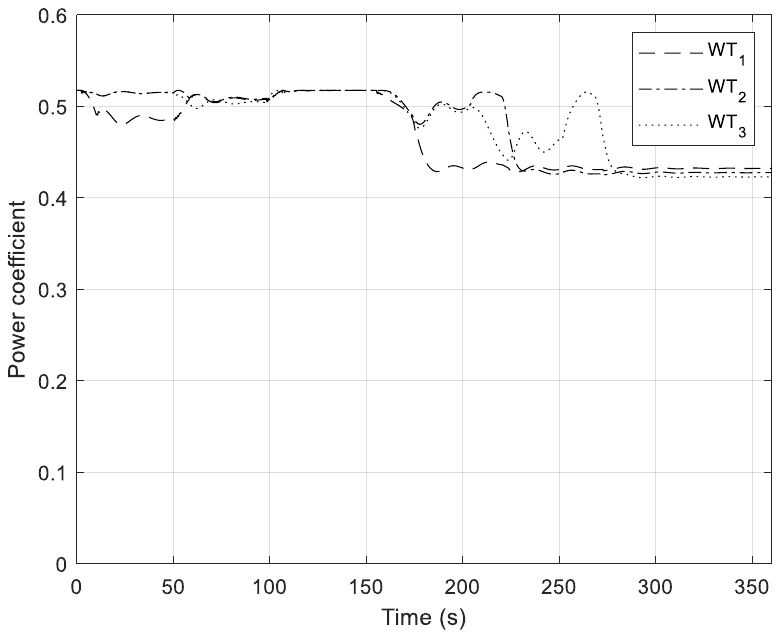
Figure 12. Power coefficient C p of the wind turbines.